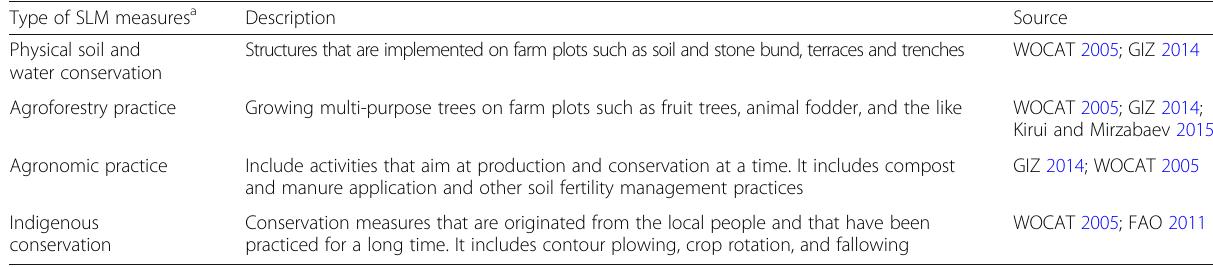
Table 2 Classification of SLM practices implemented on farmlands Type of SLM measures